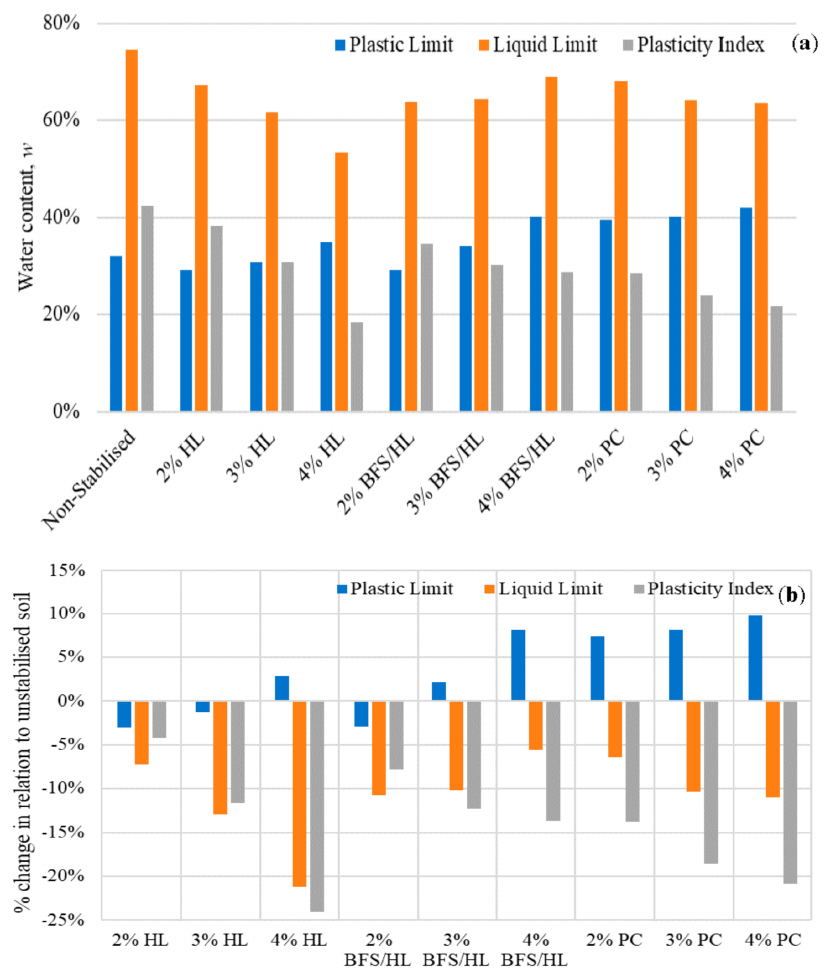
Figure 5. Summary of the results of soil index testing (Atterberg limits) having different levels of added chemical stabilisers ( a ) test results and ( b ) percentage variation of water content in relation to the non-stabilised soil (HL—Hydrated lime, BFS/HL—70/30 blend of ground granulated blast furnace slag and hydrated lime and PC-Portland